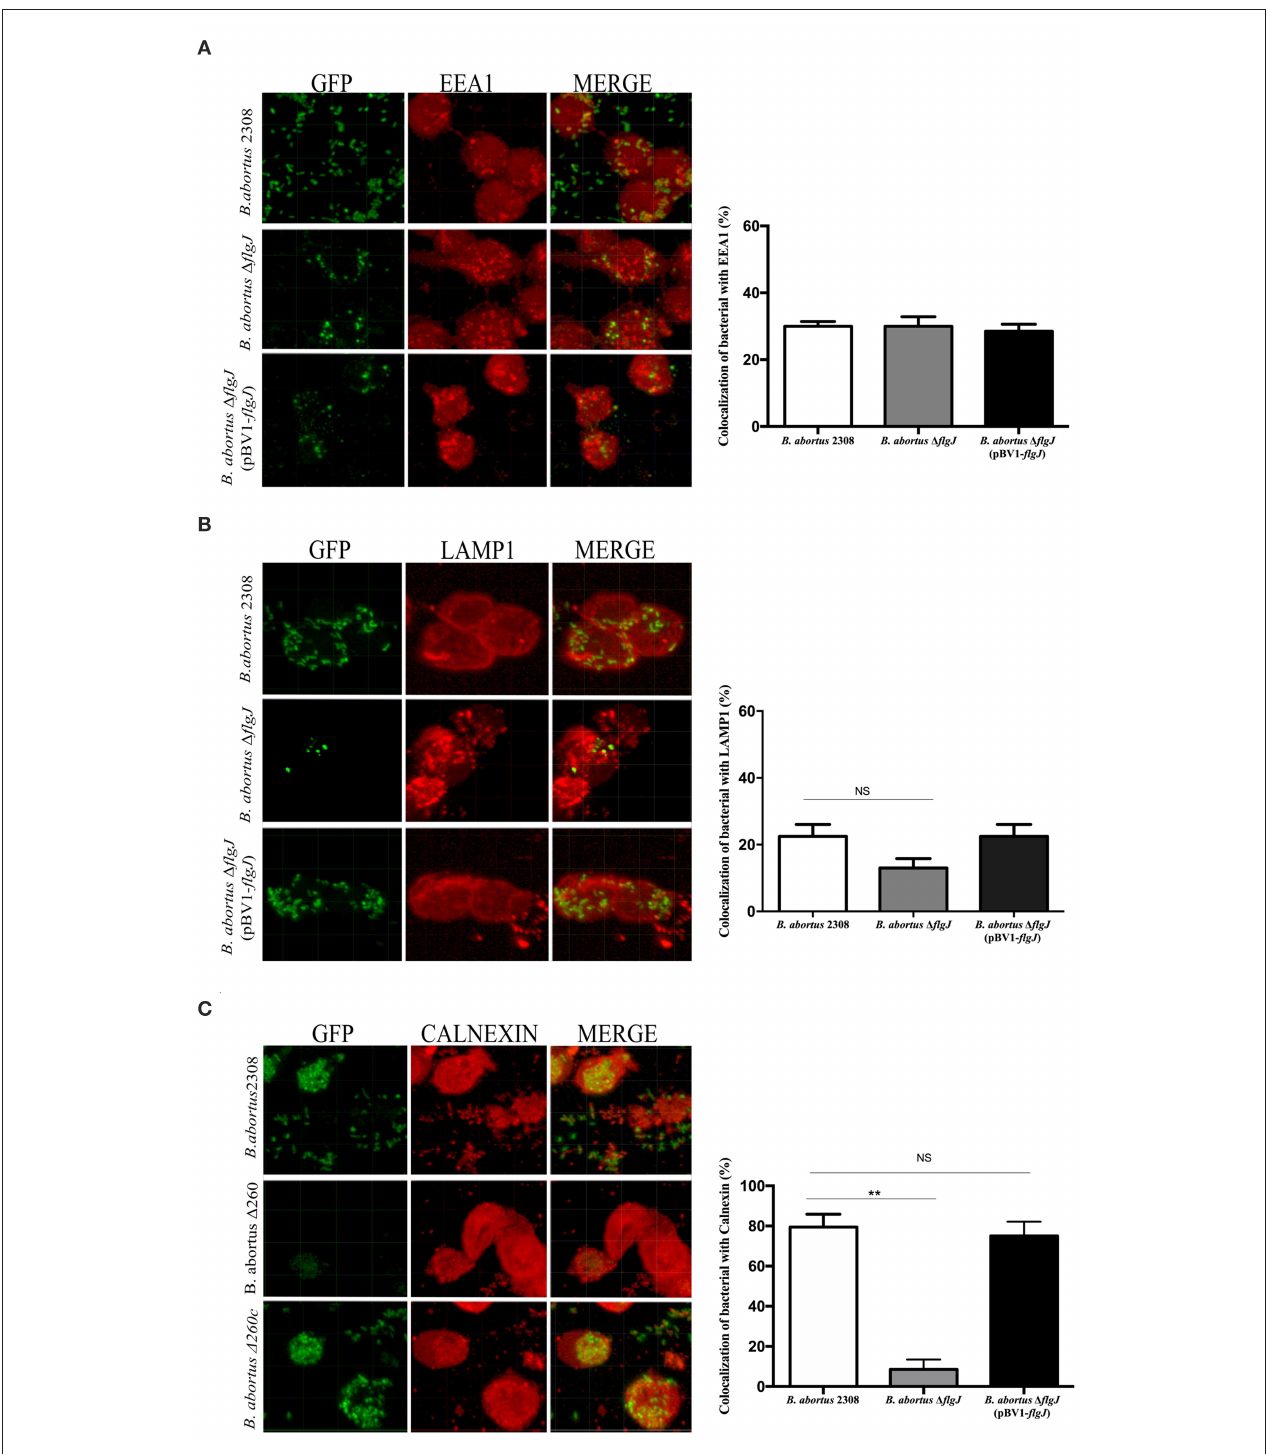
FIGURE 5 | Intracellular trafficking of B. abortus 2308 1 flgJ in macrophages. Murine macrophages RAW264.7 were infected with the Brucella strains at MOI of 50:1. Representative confocal image showing the co-localization of B. abortus 2308- gfp , B. abortus 1 flgJ-gfp and B. abortus 1 flgJ (pBV1- flgJ )- gfp strains with EEA1 protein (A) , LAMP1 protein (B) , and calnexin protein (C) . Results were expressed as mean ± standard deviation (SD), ** P < 0.01 significant.